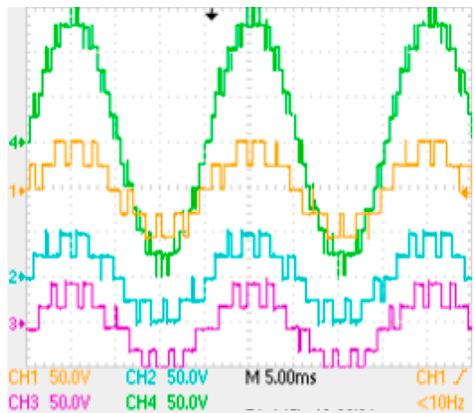
Figure 13. Switch states of PSC-SVPWM. (CH1: port voltage of Module 1; CH2: port voltage of Module 2; CH3: port voltage of Module 3; CH4: whole port voltage).